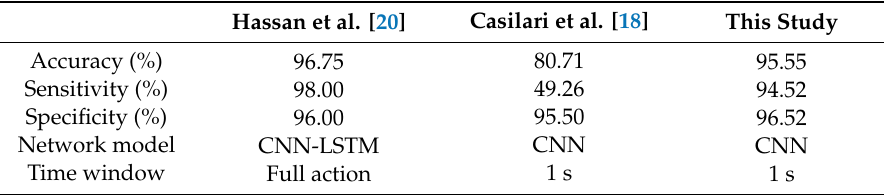
Table 2. Performance comparison with learning-based